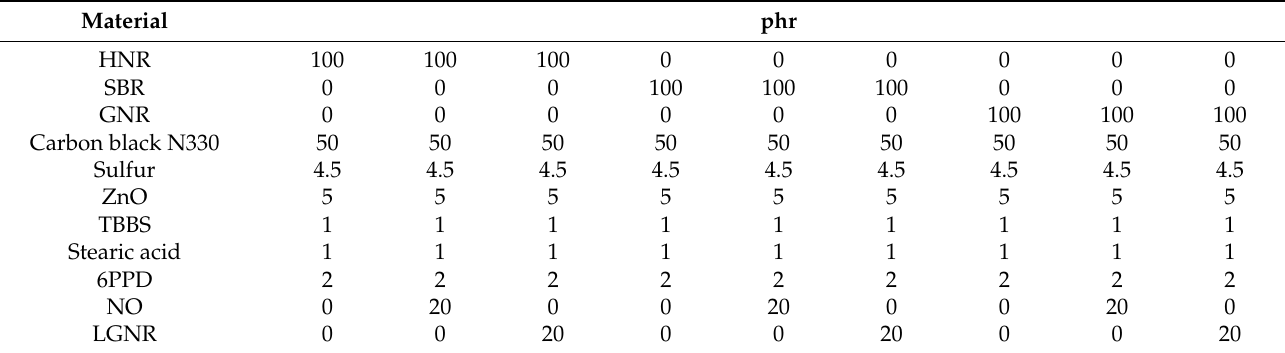
Table 1. Carbon-black-filled rubber compound compositions.